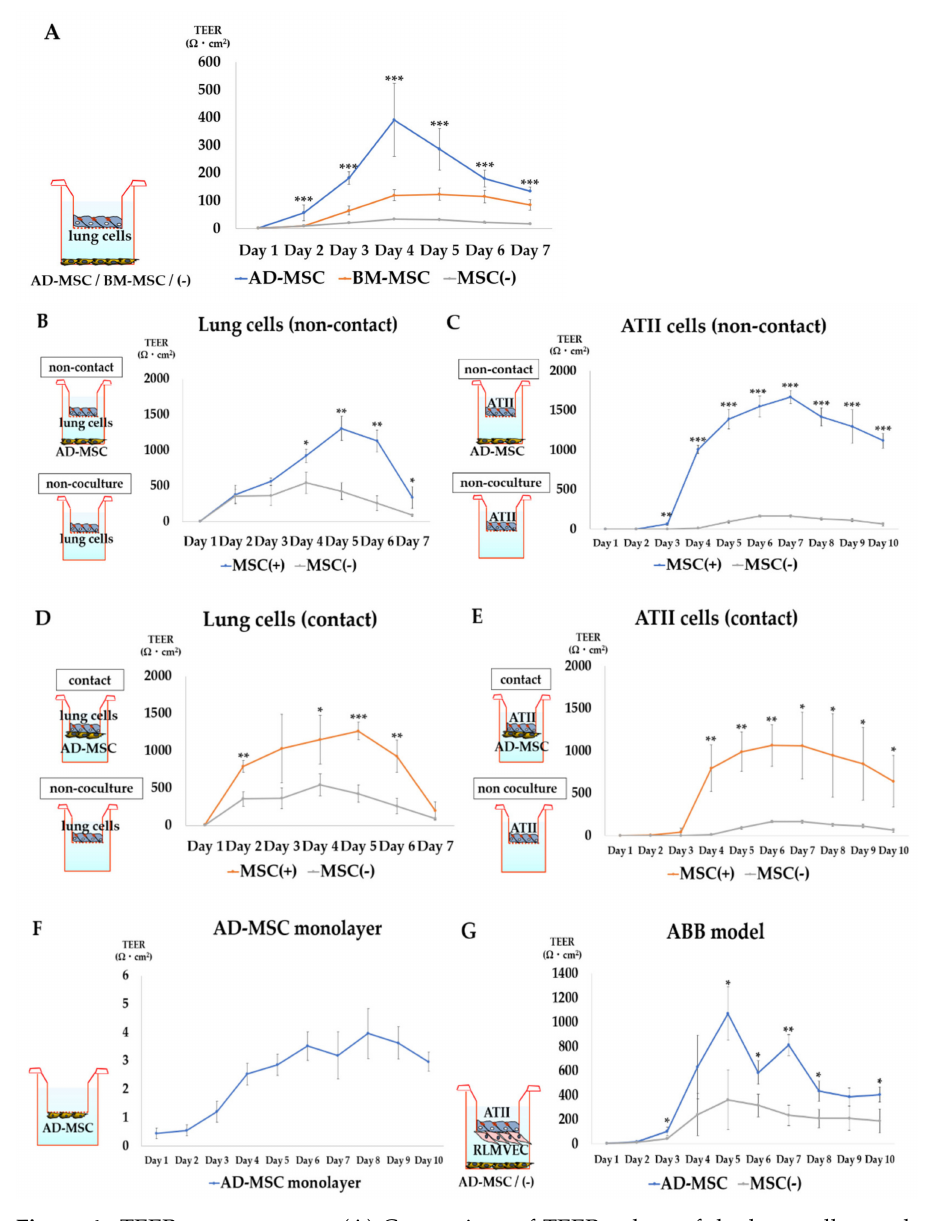
Figure 4. TEER measurement. ( A ) Comparison of TEER values of the lung cell monolayers by different origins of MSCs. ( B ) Comparison of TEER values between the non-contact AD-MSC coculture group and the non-coculture group in lung cell monolayers. ( C ) Comparison of TEER values between the non-contact AD-MSC coculture group and non-coculture group in ATII cell monolayers. ( D ) Comparison of TEER values between the contact AD-MSC coculture group and non-coculture group in lung cell monolayers. ( E ) Comparison of TEER values between the contact AD-MSC coculture group and non-coculture group in ATII cell monolayers. ( F ) TEER measurement of the AD-MSC monolayer. ( G ) Comparison of TEER values between the non-contact AD-MSC coculture group and non-coculture group in the air-blood barrier (ABB) model. All data represent means ± standard deviations; * p < 0.05, ** p < 0.01, *** p <